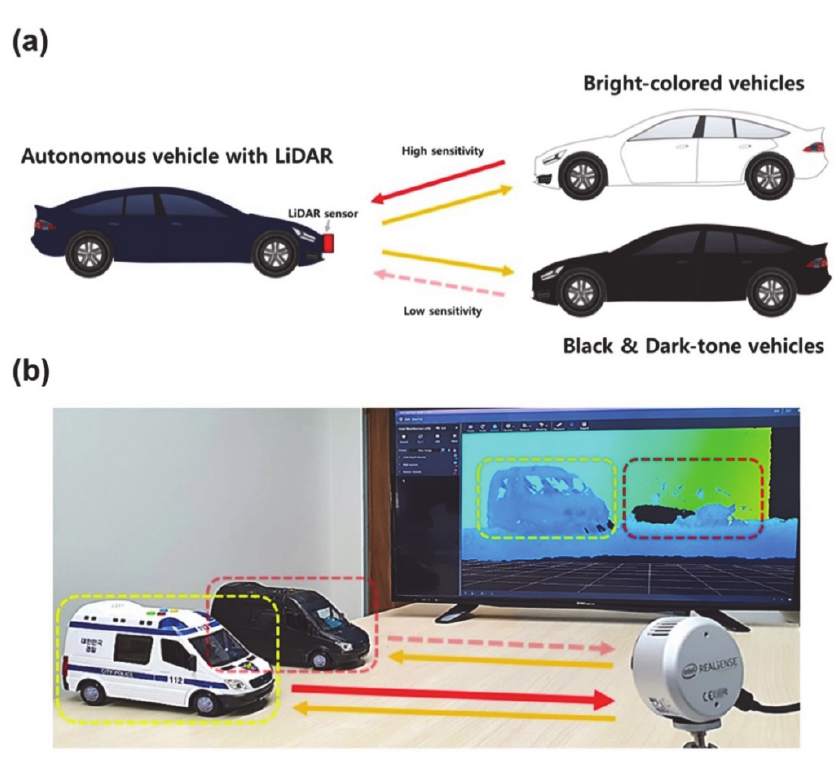
Figure 1. ( a ) Conceptual illustration of NIR reflectivity of white- and black-colored cars and their low- and high-sensitivities on LiDAR sensors. ( b ) Digital photograph of white- and black-colored car objects and their practical images on display subjected by the LiDAR sensor employing a 905 nm wavelength.